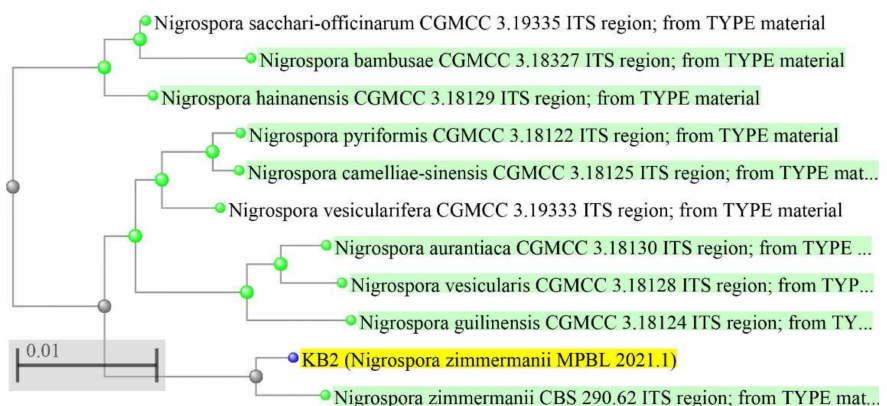
Figure 3. Phylogenetic tree with most recent common ancestor (green dot and green highlights) and the ultimate common ancestor (gray dot) of the desired isolated fungus Nigrospora zimmermanii (blue dot and yellow